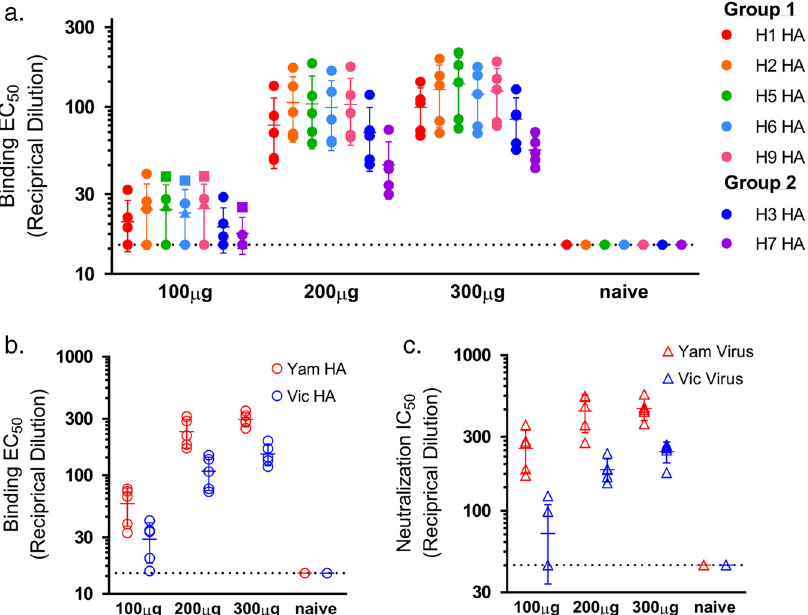
Fig. 2 Serum FluA DMAb and FluB DMAb are functional. Functional assays performed with sera from BALB/c mice collected 5 days after treatment with 100 – 300 μ g of FluA DMAb plasmid DNA ( a ) or FluB DMAb plasmid DNA ( b ) and ( c ). a ELISA binding EC 50 values (reciprocal dilution) for individual mouse serum samples to in fl uenza A HA proteins from Group 1 (H1, A/California/07/2009 H1N1; H2, A/Missouri/2006 H2N3; H5, A/Vietnam/1203/2004 H5N1; H6, A/teal/Hong Kong/W312/97 H6N1; H9, A/chicken/Hong Kong/G9/1997 H9N2) and Group 2 (H3, A/ Perth/16/2009 H3N2; H7, A/Netherlands/219/2003 H7N7). b ELISA Binding EC 50 values (reciprocal dilution) for individual mouse serum samples to in fl uenza B HA proteins from the Yamagata (Yam B/Florida/4/2006) and Victoria (Vic B/Brisbane/60/2008) lineages. c Neutralization IC 50 values (reciprocal dilution) for individual mouse serum samples against in fl uenza B viruses from the Yamagata (Yam virus B/Florida/4/ 2006) and Victoria (Vic virus B/Malaysia/2506/2004) lineages. ( n = 5 animals per group, mean ± SD)